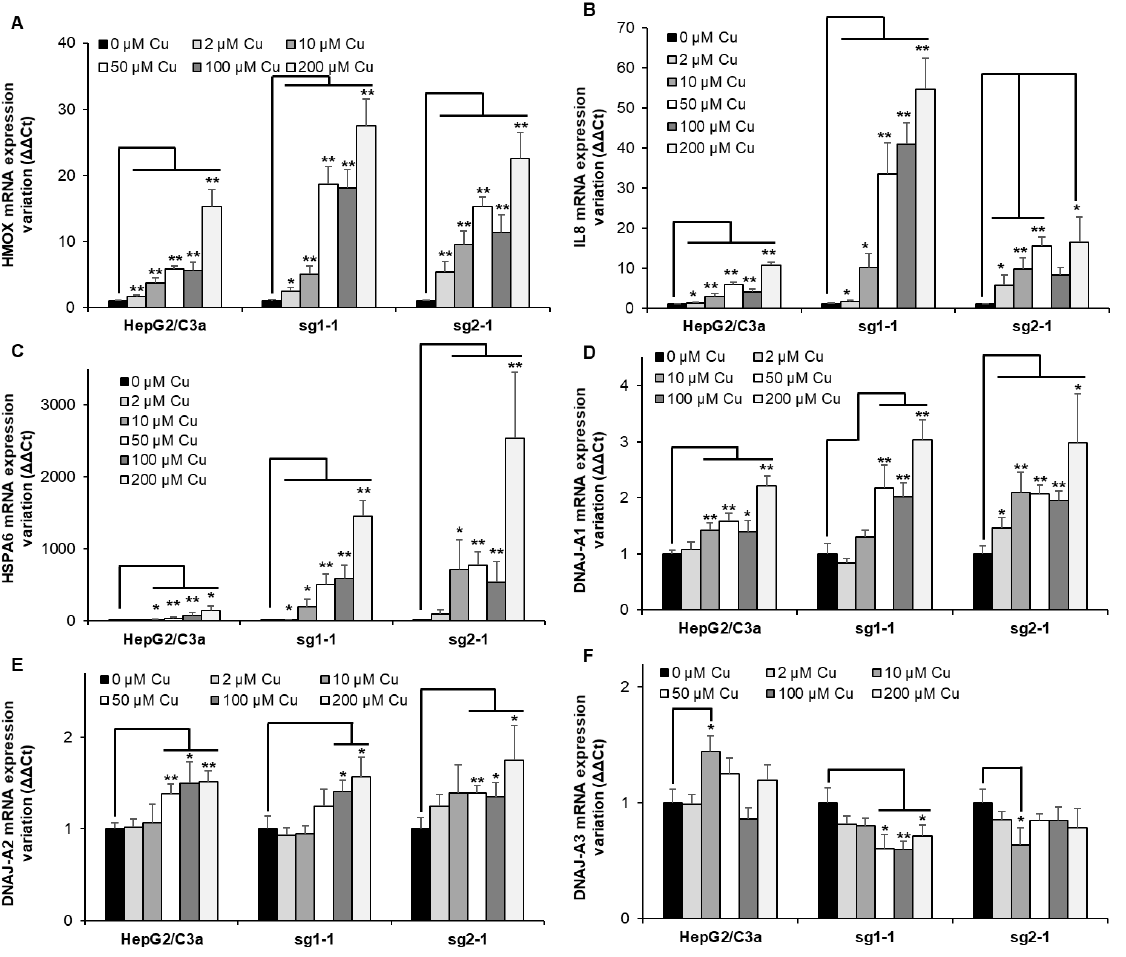
Figure 6. Inflammatory responses and protein misfolding in cell lines with or without ATP7B. HepG2/C3a, sg1-1, and sg2-1 cells were exposed to increasing concentrations of Cu. HMOX ( A ), IL8 ( B ), HSPA6 ( C ), DNAJ-A1 ( D ), DNAJ-A2 ( E ), and DNAJ-A3 ( F ) mRNA variation expression were